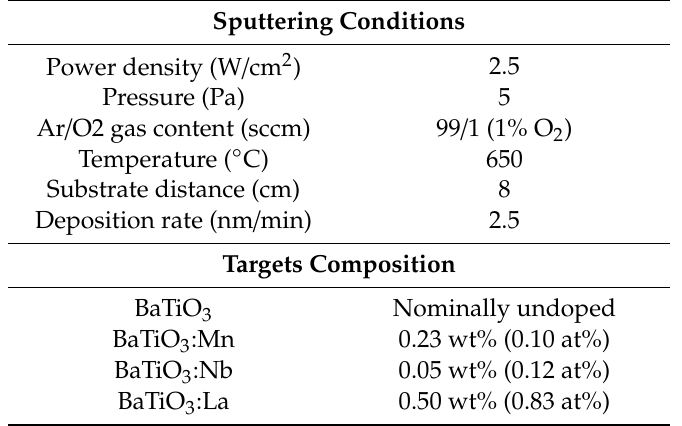
Table 1. Physical vapor deposition (PVD) sputtering conditions for (un) doped BaTiO 3 (BTO) thin films and doping concentration of